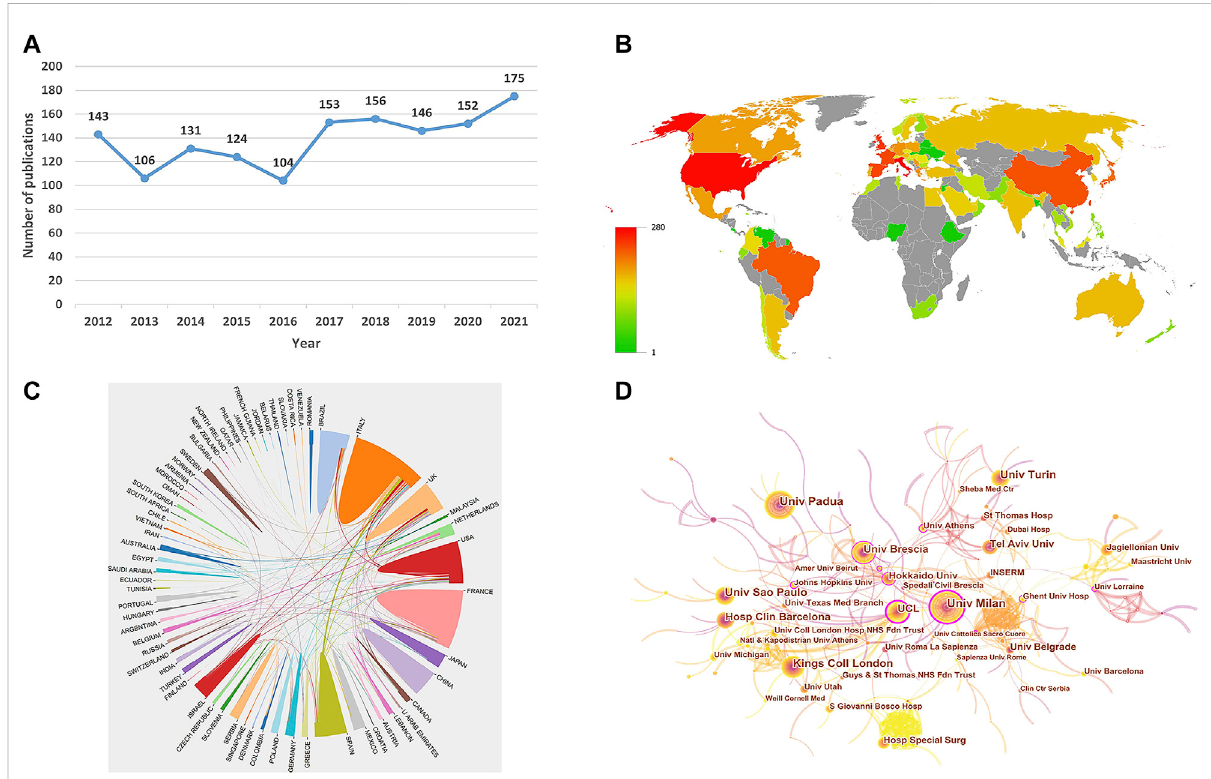
FIGURE 2 (A) Annual outputs of antiphospholipid syndrome (APS) from 2012 to 2021. (B) Map distribution on the sources of APS publications. (C) International cooperation analysis among countries by an online analysis platform. The curve between countries re fl ects the closeness of cooperation,thickerlinesindicateclosercooperation. (D) InternationalcooperationanalysisamonginstitutionsbyCiteSpace.Eachcirclerepresents aninstitution,andthesizeofthecircleisproportionaltothepublicationcount.Thecircleswithhighercentrality( > 0.1)aredisplayedwithpurple rings. The lines represent the strength of the co-authorship relationship, with thicker lines representing stronger collaboration. The color of the line represents the time of the fi rst co-authorship, with a more yellow color meaning closer to 2021 and a more red color meaning closer to 2012.